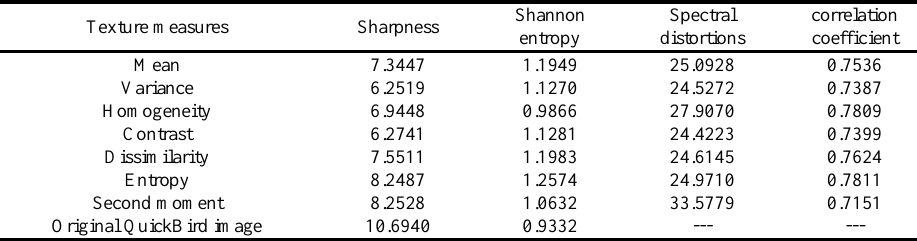
Table 1. Evaluation of PCA fusion based on texture